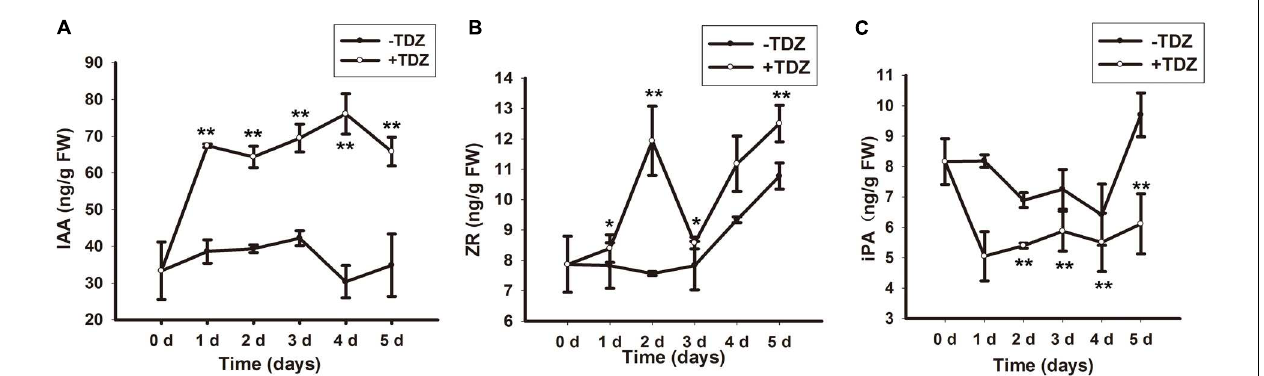
FIGURE 1 | Endogenous IAA, ZR and iPA levels in callus-rhizoids after culture on PIM. Callus-rhizoids (0.2 g fresh) were collected after culture on PIM (1/2 MS + 20 mg/L TDZ) or 1/2 MS media without TDZ for 0, 1, 2, 3, 4, or 5 days. (A) The level of IAA and ZR was significantly increased by TDZ during the first 5 days of culture on PIM. (B) The endogenous level of ZR was repressed by TDZ. (C) The endogenous level of iPA was increased by TDZ, especially on day 2. Error bars represent the SE of three biological replicates. Asterisks indicate significant ( ∗ P < 0.05) or highly significant ( ∗∗ P < 0.01) differences calculated using the t -test ( n = 9 for each